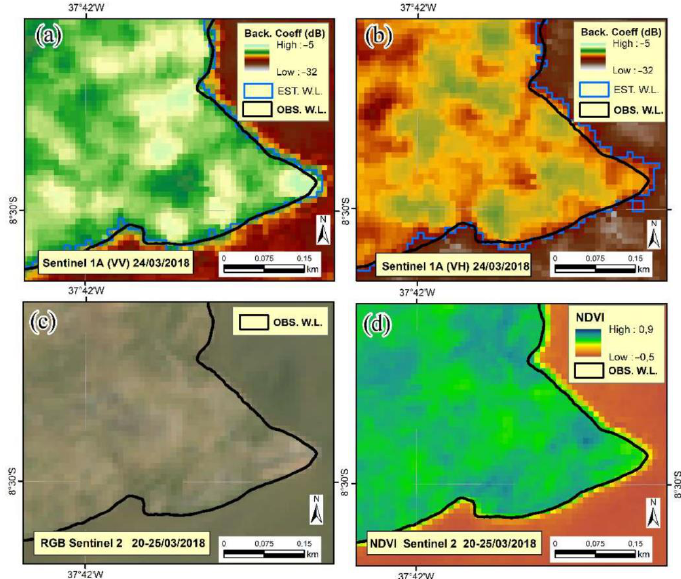
Figure 18. Typical depletion zone image features in the dry season: ( a ) VV backscattering; ( b ) VH backscattering; ( c ) RGB composition; and ( d ) NDVI composite. OBS. W.L indicates observed water level.